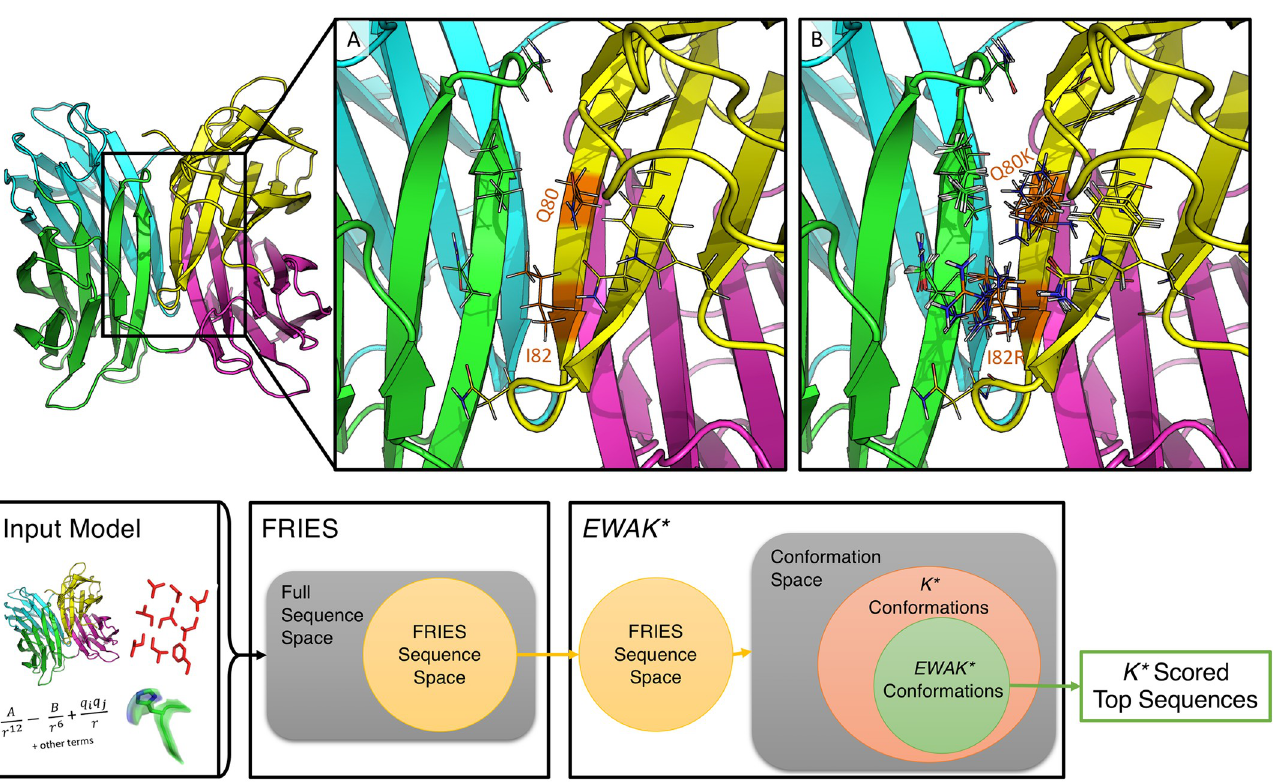
Fig 1. Design example using the structure of the LecB lectin Pseudomonas aeruginosa strain PA14 (PDB ID: 5A6Y [67]) and the OSPREY workflow for FRIES / EWAK � . In the top panel, the full, 4 domain structure of lectin is shown on the left-hand side. (A) Zooming in on the region where domains A (green) and D (yellow) interact, showing the two mutable residues (Q80 and I82) along with the surrounding flexible shell of residues as lines. There were 11 flexible residues included in this design with Q80 and I82 allowed to mutate to all other amino acids except for proline. This design consisted of 8.102 × 10 11 conformations and 441 sequences. FRIES limited this space to 5.704 × 10 11 conformations and 206 sequences. FRIES / EWAK � in combination reduced the amount of time taken by about 75% compared to BBK � . FRIES alone was responsible for roughly 50% of this speed-up. (B) 10 low-energy conformations included in the thermodynamic ensemble of the design sequence with mutations Q80I and I82F. For this particular sequence, BBK � minimized 10,664 conformations while EWAK � minimized only 4,104 conformations. The bottom panel shows the general workflow for FRIES / EWAK � . The workflow begins with the input model (as described in the Section entitled “Computational materials and methods”), which defines the design space for the first algorithm, FRIES . FRIES proceeds to prune the sequence space as described in the Section entitled “Fast Removal of Inadequately Energied Sequences ( FRIES )” and as illustrated in the Venn diagram with the unpruned space shown as a yellow disk. Next, the remaining FRIES sequence space defines the conformation space (which contains multiple sequences as well as conformations) searched with EWAK � . EWAK � limits the conformations included in each partition function as described in the Section entitled “Energy Window Approximation to K � ( EWAK � ).” EWAK � generally searches over only a subset of the conformations (green area) that previous K � -based algorithms like BBK � [32] search (orange area). EWAK � then returns the top sequences based on decreasing K �